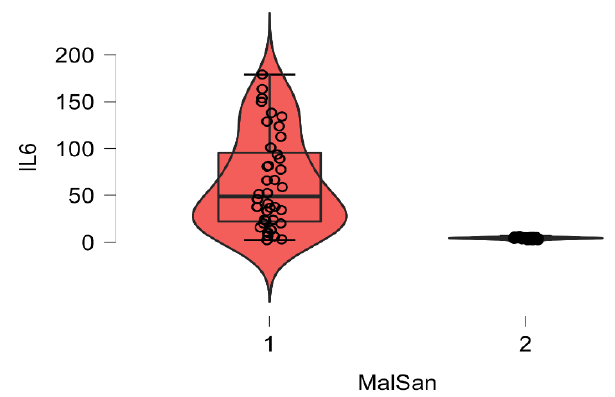
Figure 4. Boxplot showing the plasma concentration of IL-6 within 48 h of hospitalization in patients with COVID-19 (red) and healthy individuals.